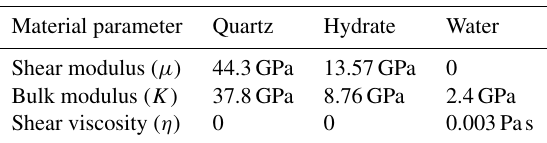
Figure 7. Fundamental block of an idealized periodic medium rep- resenting sediment grains which are separated from the embedding GH background by a thin interfacial water film. Table 1. Material properties used in the numerical simulations. The properties of quartz are based on the work of Bass (1995) and those of hydrate on Helgerud